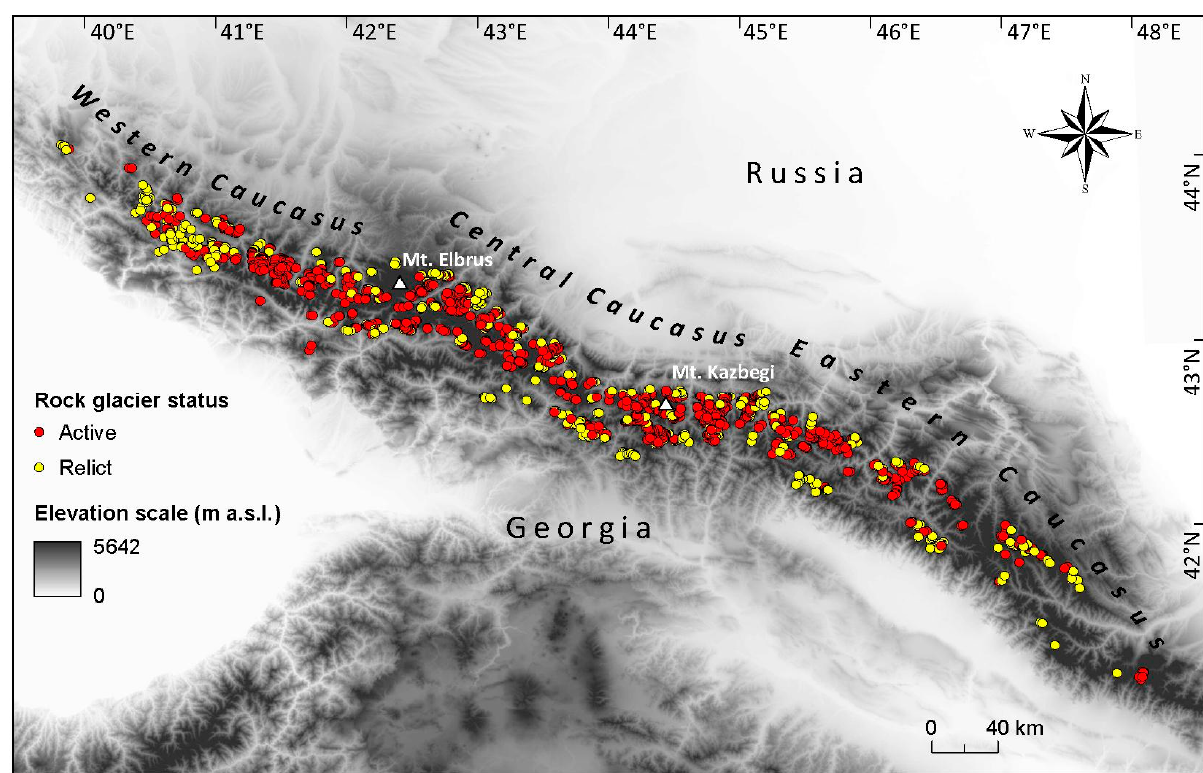
Figure 4. Color-coded map of active and relict rock glaciers for the Greater Caucasus. The average minimum elevation of all Caucasus rock glaciers was 2282 ± 87 m a.s.l., while the average maximum elevation was 3153 ± 92 m a.s.l. (Figure 5a). Relict rock glac- iers had lower mean average snout position at 2716 ± 83 m a.s.l., while active rock glaciers had higher mean average snout positions at 2955 ± 98 m a.s.l. (Figure 5b).